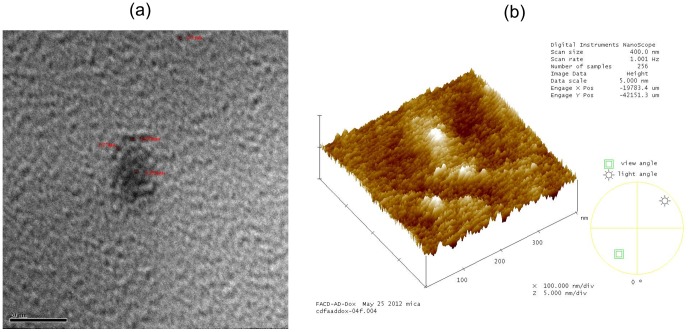
The TEM (a) and AFM (b) images of FACD-Ada-Dox molecules.